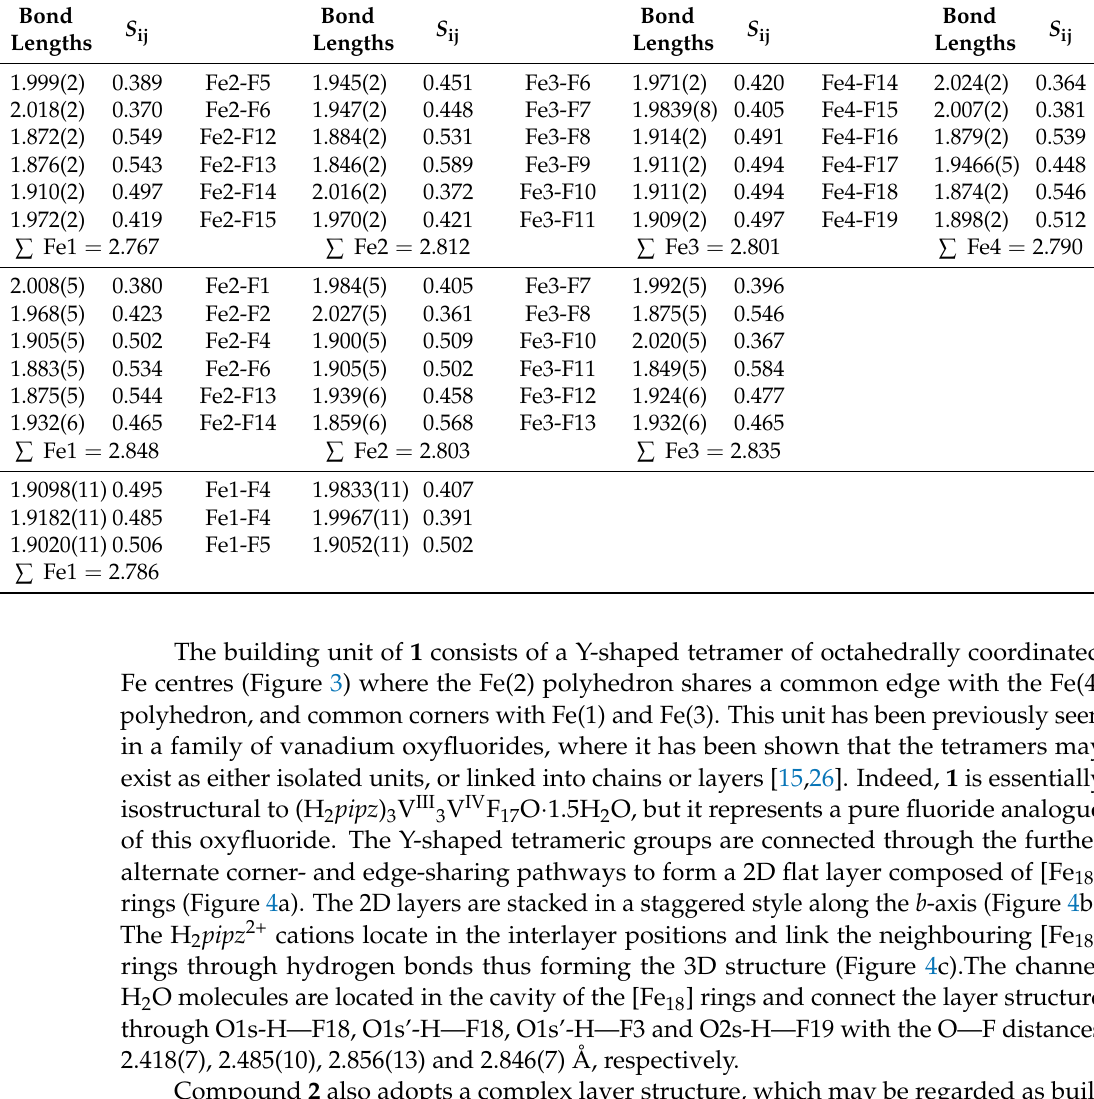
Table 2. Selected bond distances (Å) and bond valence sums, S (valence units) for 1 , 2 , and 3